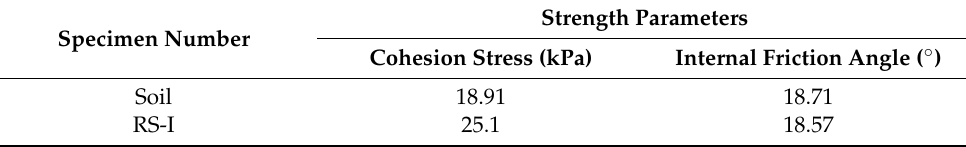
Table 7. Shear strength and strength parameters of root-bearing soil in the direct shear test.